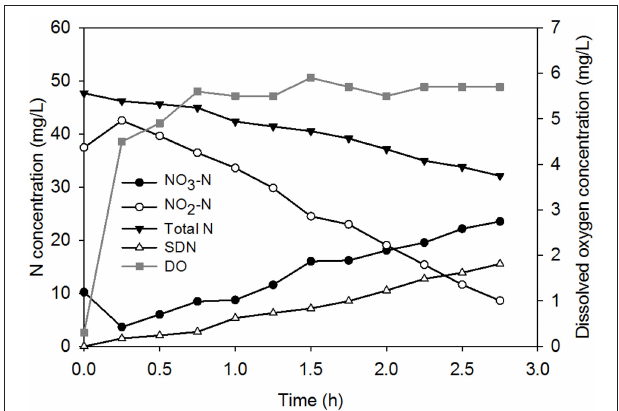
FIGURE 2 | Kinetic NOx-N measurements during the aerobic period of an arbitrarily chosen SBR cycle (SDN, simultaneous denitrification; DO, dissolved oxygen concentration).